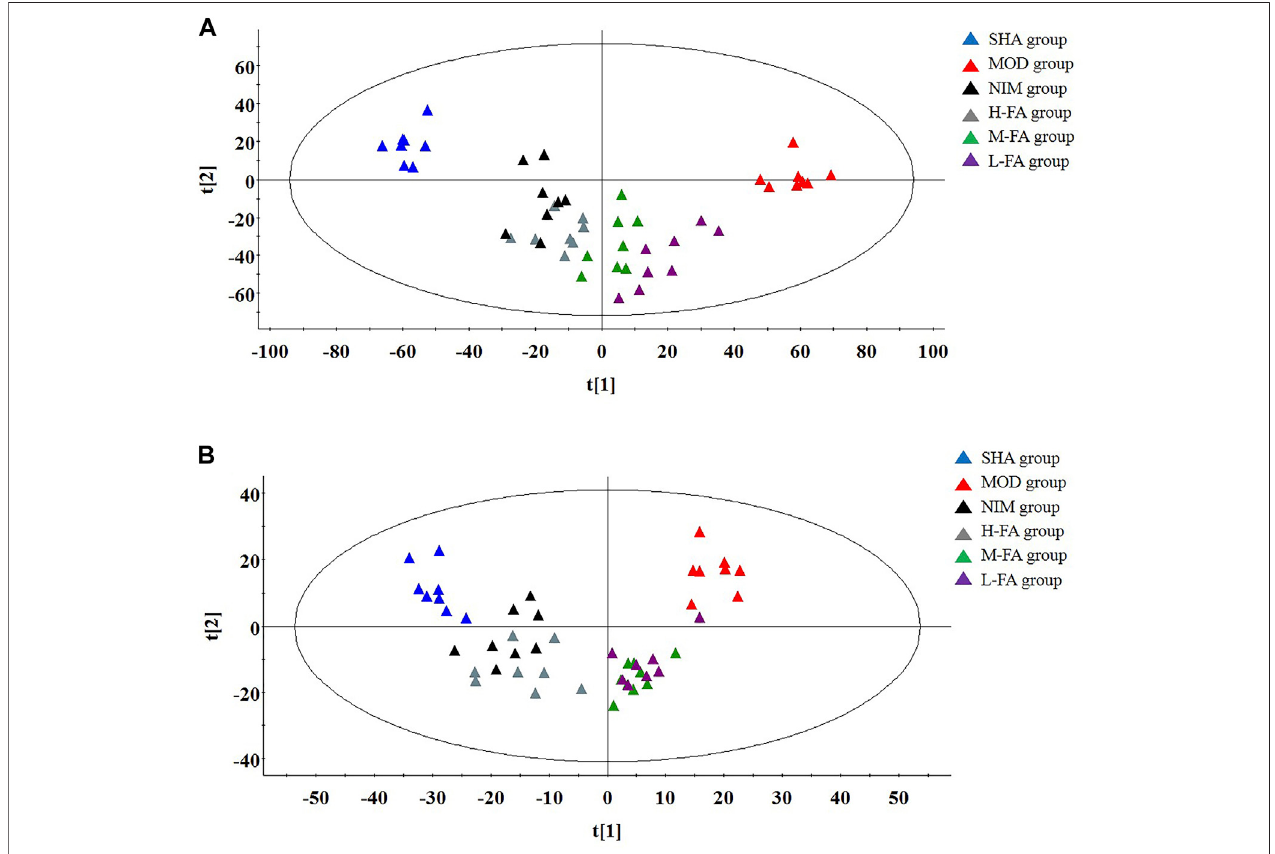
FIGURE 3 | In positive ion mode: PCA score plots present a separate trajectory of metabolites in brain tissue among the SHA, MOD, NIM, L-FA, M-FA, and H-FA groups ( n = 8 in every group) (A) . In negative ion mode: PCA score plots present a separate trajectory of metabolites in brain tissue among the SHA, MOD, NIM, L-FA, M-FA, and H-FA groups (B)